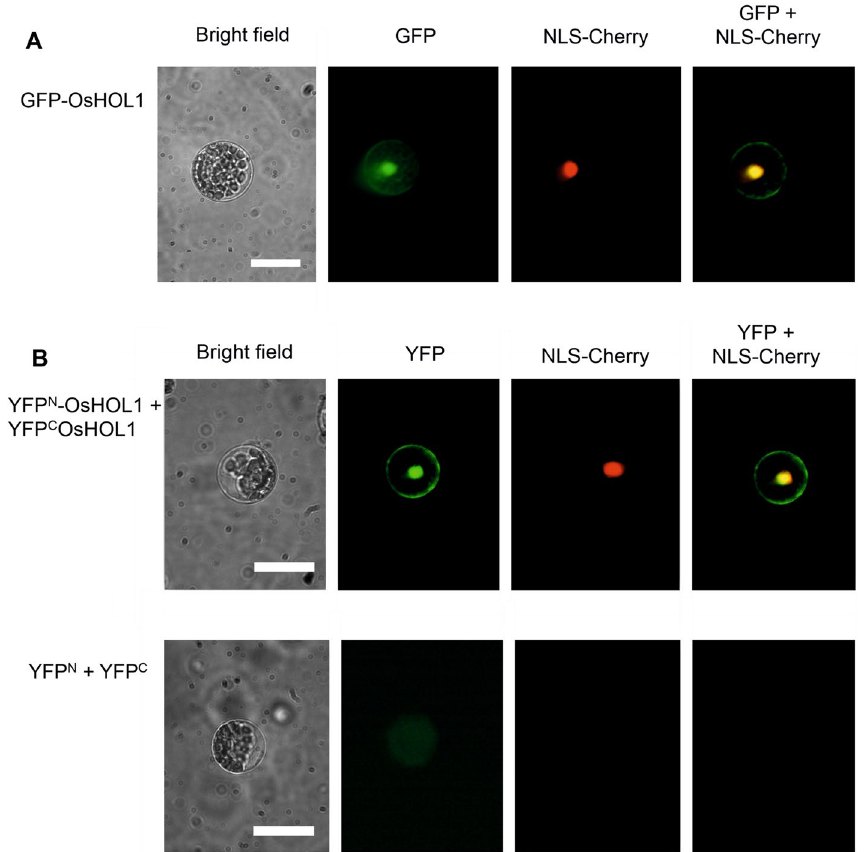
Figure 4. Cell localization and BiFC assay of OsHOL1 proteins. ( A ) Subcellular localization of OsHOL1, transiently expressed in Arabidopsis protoplasts as fusion proteins with GFP. GFP, NLS-Cherry RFP and merged GFP + NLS-Cherry RFP fluorescence and bright field images of protoplasts are shown. ( B ) Protein–protein BiFC interaction analysis of OsHOL1. OsHOL1-YFP C + OsHOL1-YFP N fusion proteins, and YFP N + YFP C split proteins were co-expressed in Arabidopsis protoplasts, as indicated in the picture. BiFC was detected from reconstitution of the YFP signal. Individual and merged images of YFP and NLS-Cherry RFP as well as bright field images of protoplasts are shown. Scale bars = 10